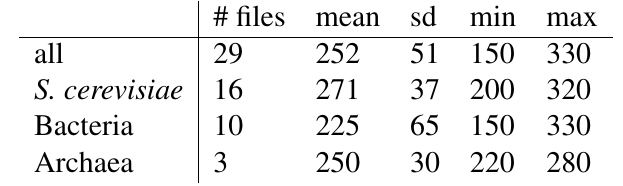
Figure 1: Plot of the inter-STOP symbol distances for 10000 trinucleotides of the Saccharomyces cerevisiae chromosome I in the three frames. The coding regions are marked with thick red lines. Table 2: Description summary of cut-off distance corresponding to best AUC for each group of